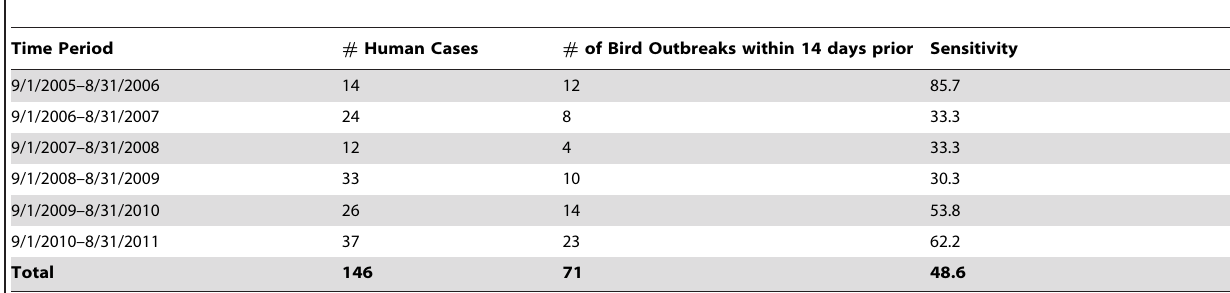
Table 4. Sensitivity for bird outbreaks predicting the occurrence of a human case of H5N1 HPAI in the same governorate within the next 14